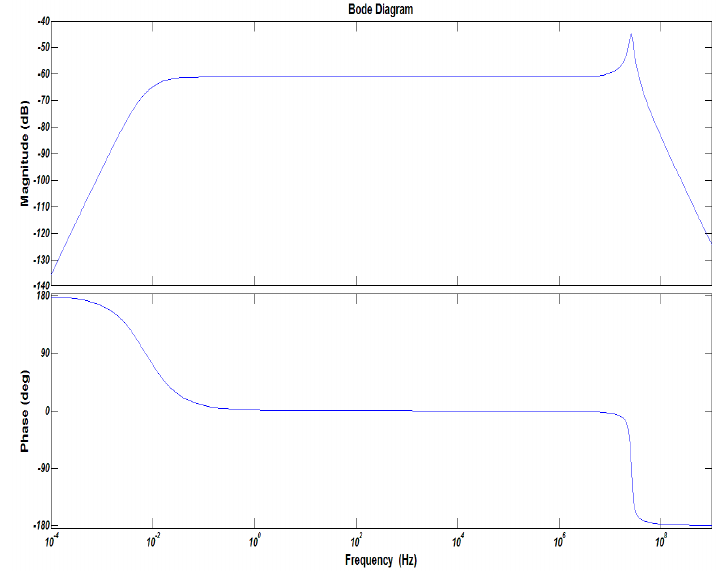
Figure 10. The frequency response of the proposed sensor.